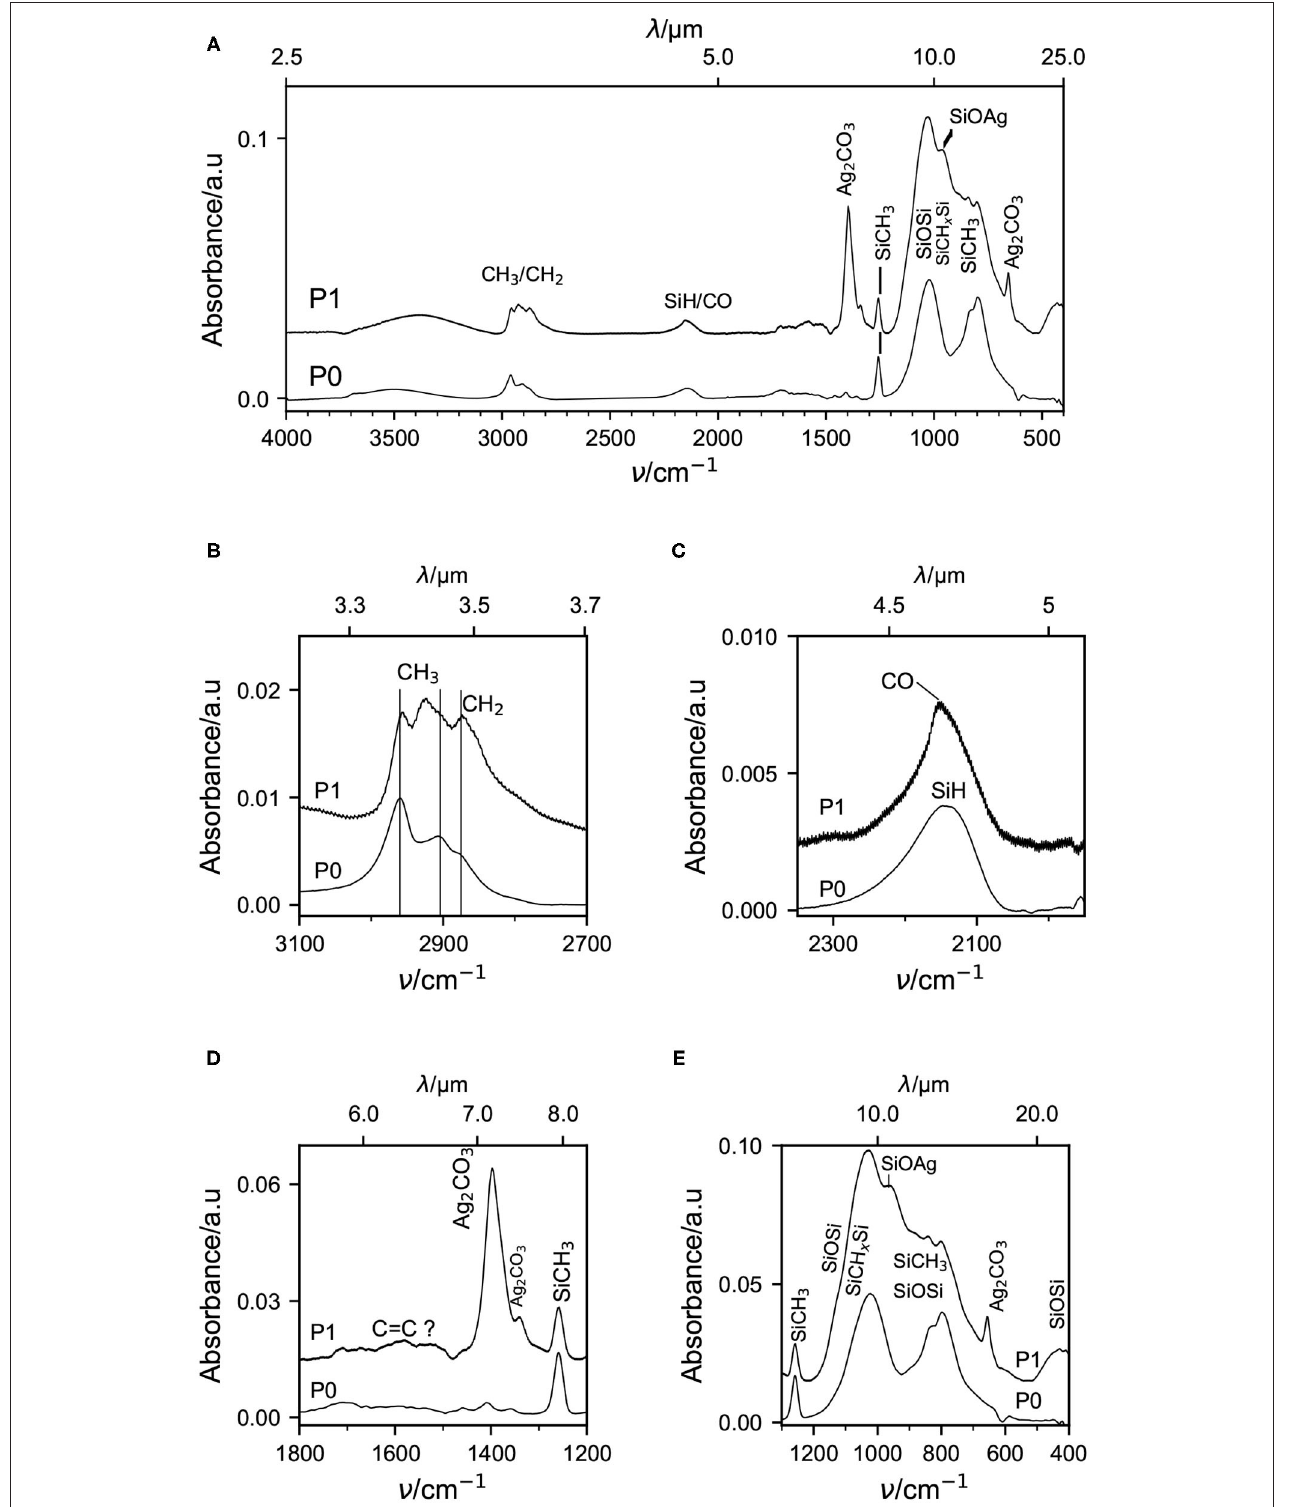
FIGURE 2 | ESPOIRS-FTIR spectra of the collected dust in plasma experiments. (A) Full IR spectrum for samples P0 (without silver) and P1 (with silver) with the principal band attributions indicated (see text for more details). Zooms in on the most interesting spectral regions are presented in (B–E) .